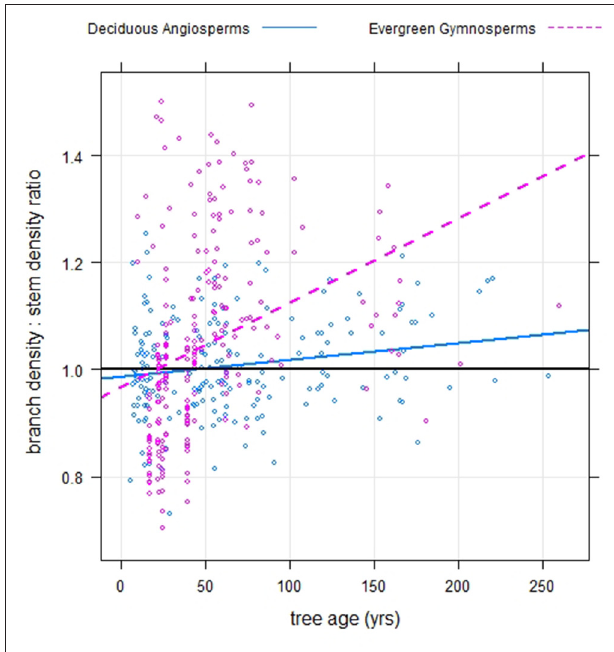
FIGURE 9 | Branch wood – stem wood basic density relationships for North American trees (circles) of different ages within two phylogenetic groupings- evergreen gymnosperms and deciduous